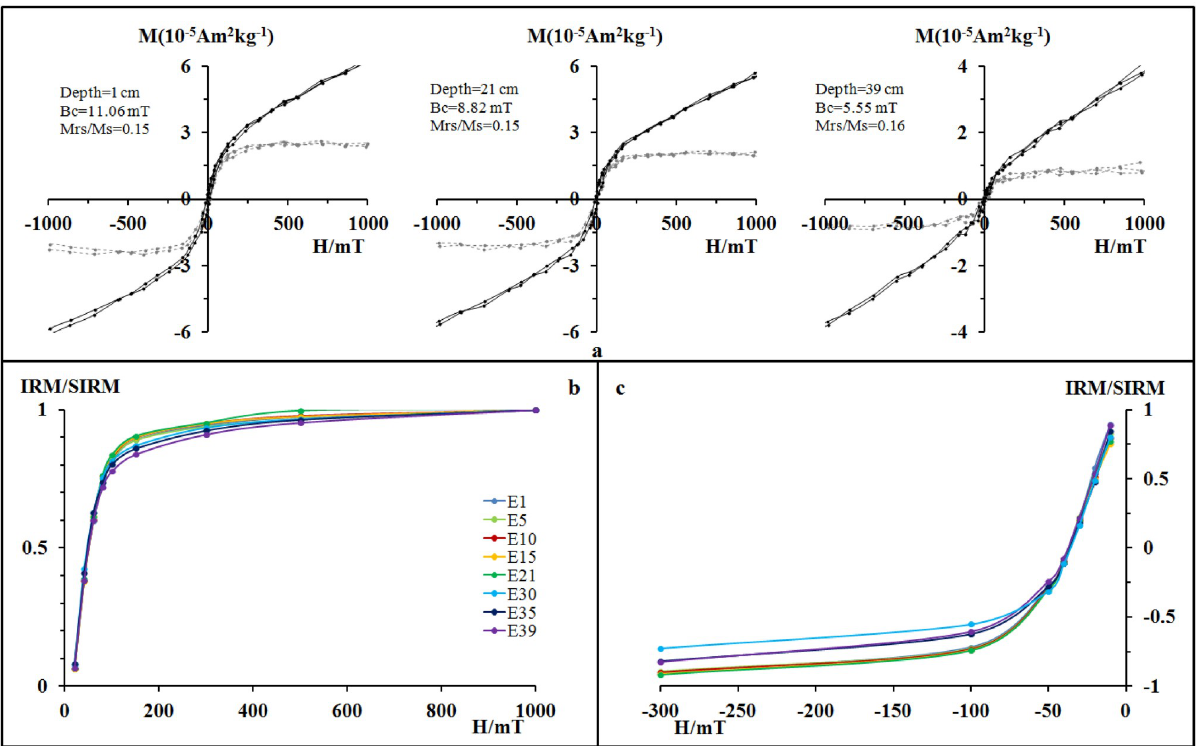
Fig 3. Magnetic hysteresis loops (a) (the black lines indicate the original curves, and the grey lines indicate the slope-corrected curves), IRM acquisition curves (b), and backfield curves (c) of pilot samples. The numbers after E indicate the depth in